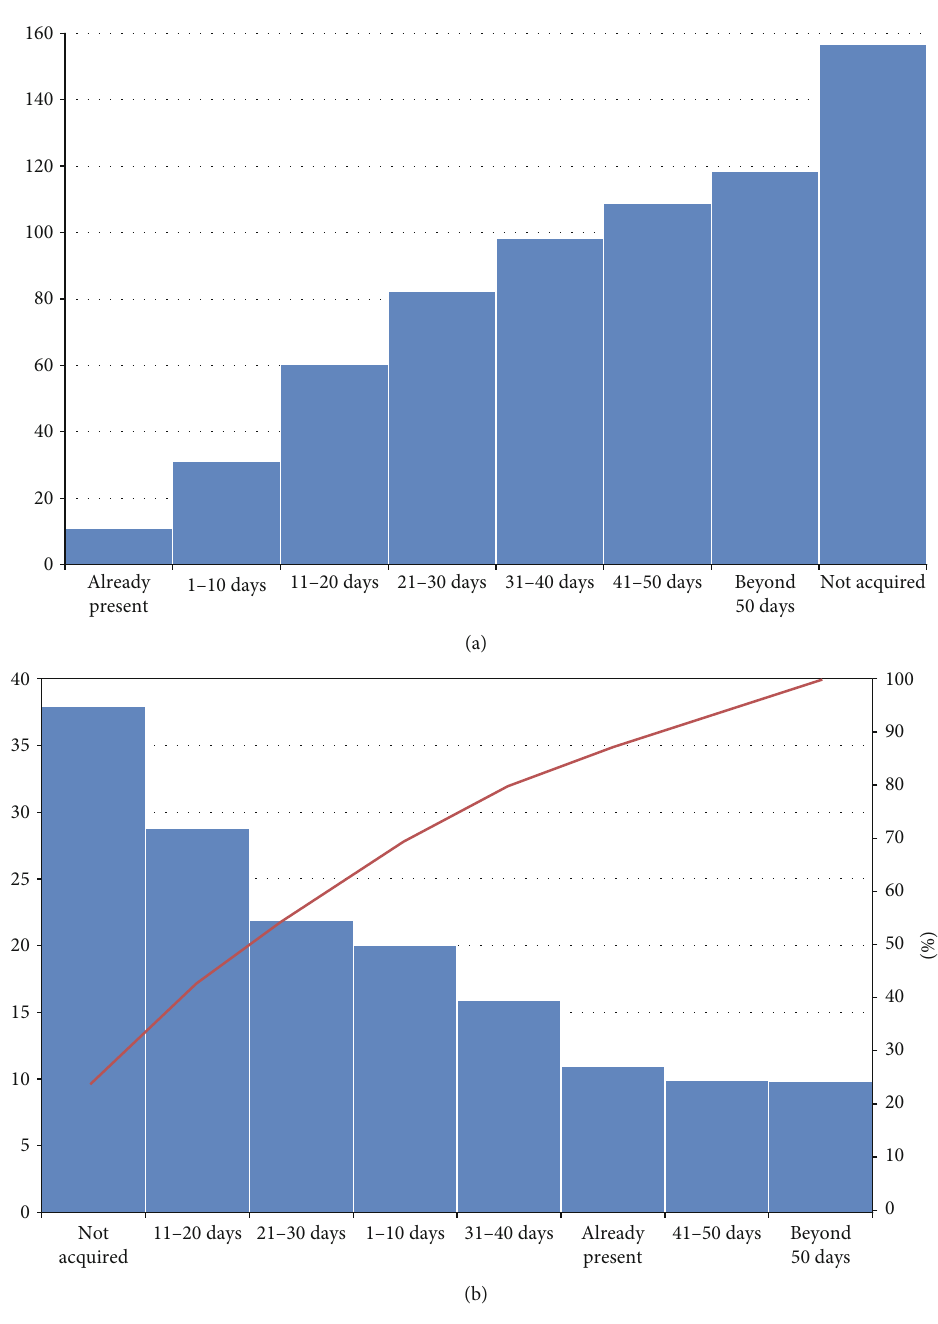
Figure 3: (a) Cumulative frequencies of autonomous walking acquisition times; abscissa, times of milestone acquisition; ordinate, absolute number of patients. (b) Single frequencies of milestone acquisition, ordered according to their frequency; columns, absolute number of patients; line, cumulative